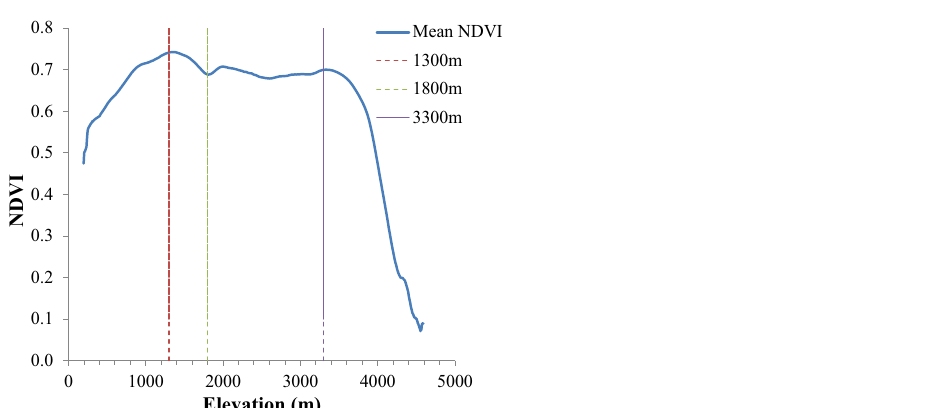
Figure 2. Change trend ( a ) and abrupt point analysis ( b ) of maximum NDVI in growing seasons in Qin Mountains (1987–2018). The change trend of maximum NDVI in growing seasons extracted from Google Earth Engine (GEE). The points that transformation from upward to downward has been considered as the abrupt change of data sequence, and the “Statistics Value” in the y-axis refer to the accumulated departure. Besides, considered the implementation of “Grain For Green Project” in 1999 in China, we divided the whole study time into three periods: 1987–1999, 1999–2006, 2006–2018.